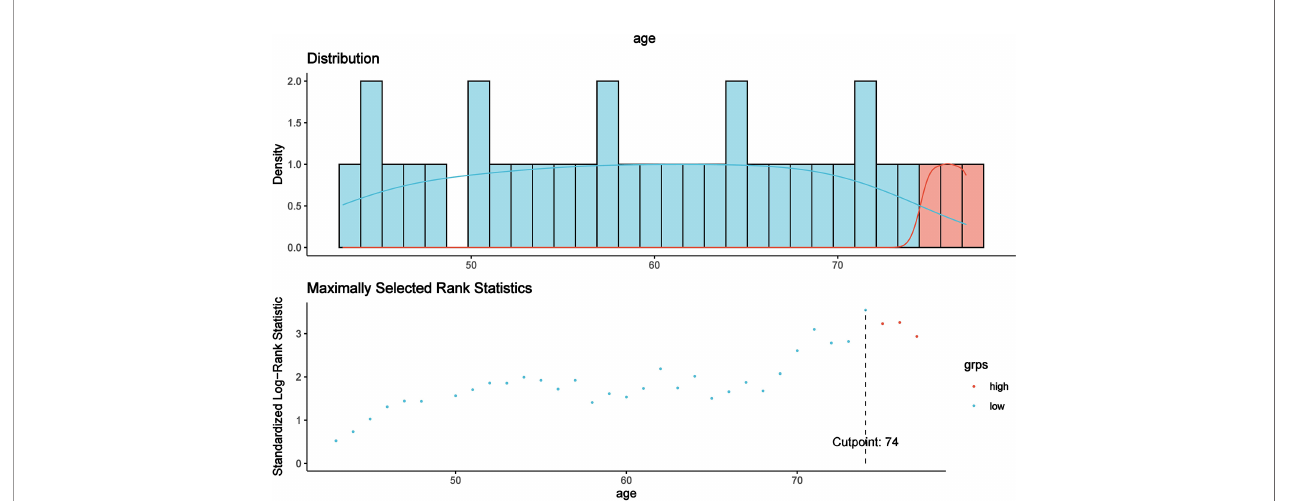
FIGURE 3 | The optimal cutoff point for age was found to be 74 years using the MaxStat method, which distinguished two prognostic groups most effectively ( P < 0.0001).